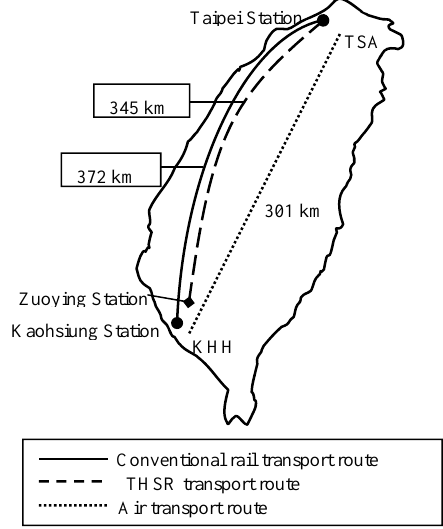
Figure 2. The transport routes between Taipei and Kaohsiung.